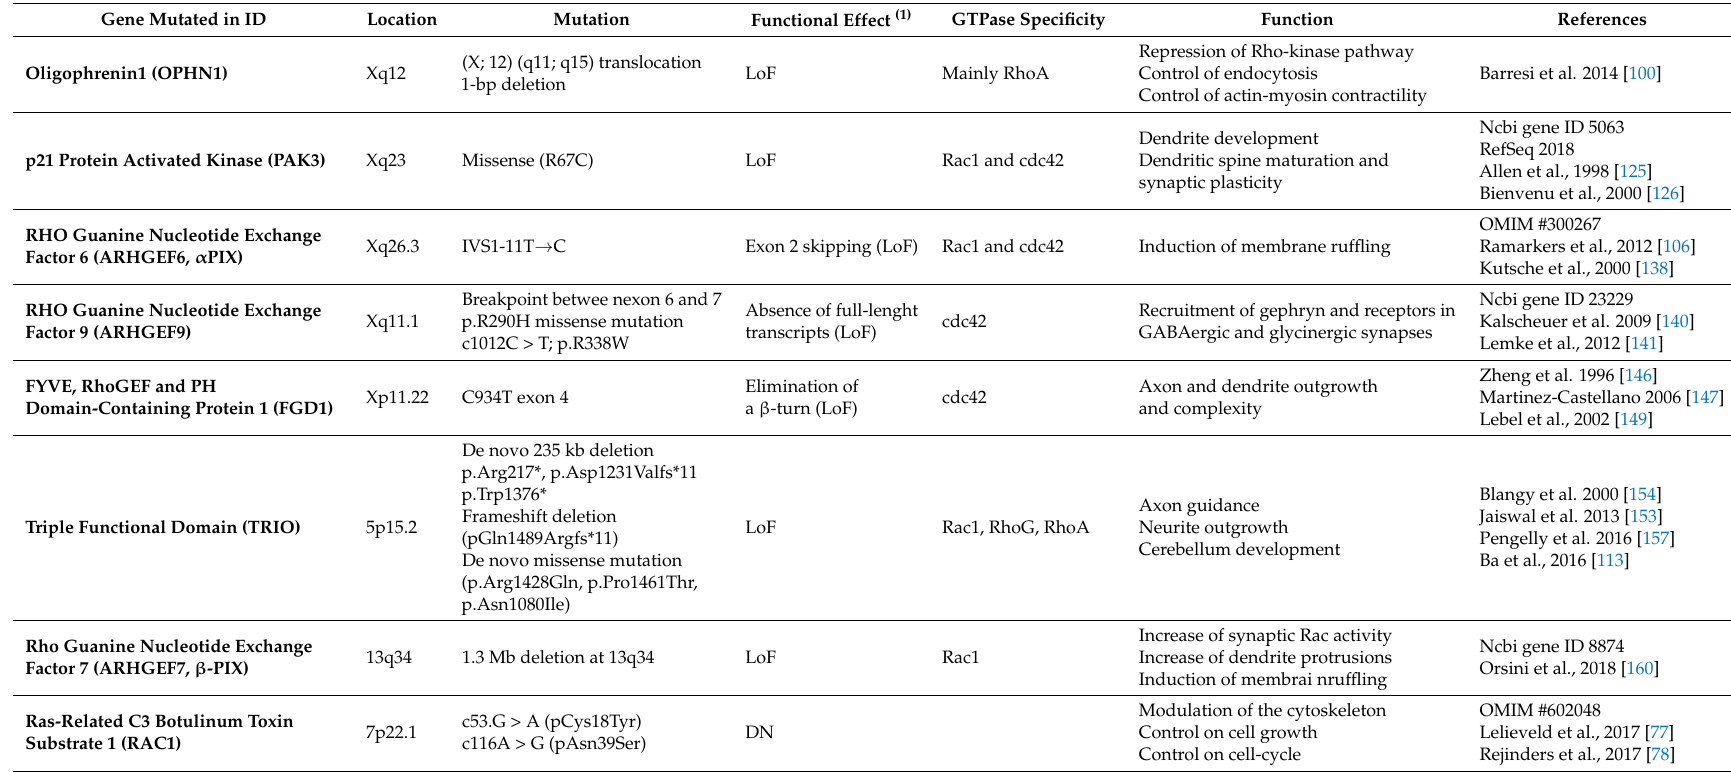
Table 2. GTPase specificity of genes involved in human